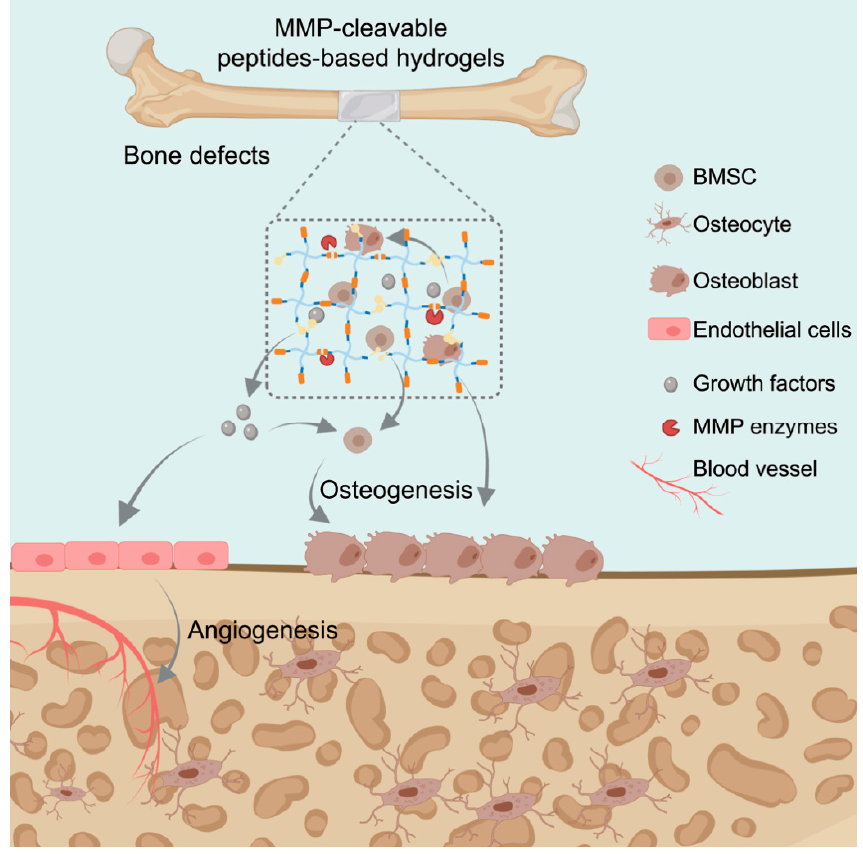
Figure 7. Illustration diagram of MMP-cleavable peptides-based hydrogels for bone healing.